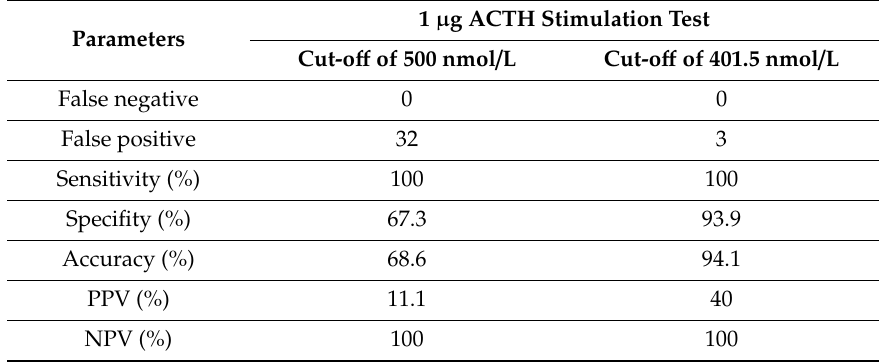
Table 2. Performances of 1 µ g ACTH stimulation for cut-o ff levels of 500 nmol / L and 401.5 nmol /